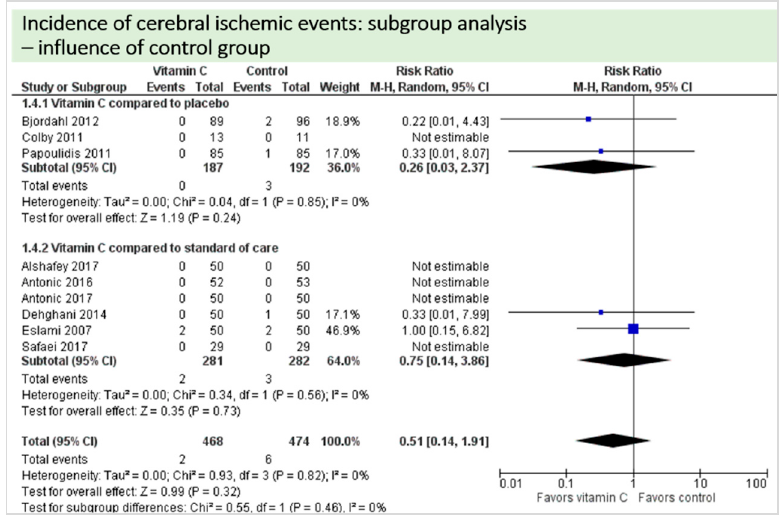
Figure 16. Cerebral ischemic events: subgroup analysis—influence of control group.